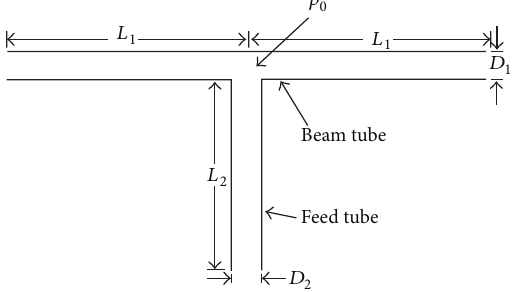
Figure 3: Storage cell geometry. The proton beam is traversing the beam tube of total length 2𝐿 1 ; the polarized atomic beam enters “ballistically” via the feed tube into the center and diffuses outwards along the three tube elements with a density maximum 𝜌 0 in the center (figure taken from